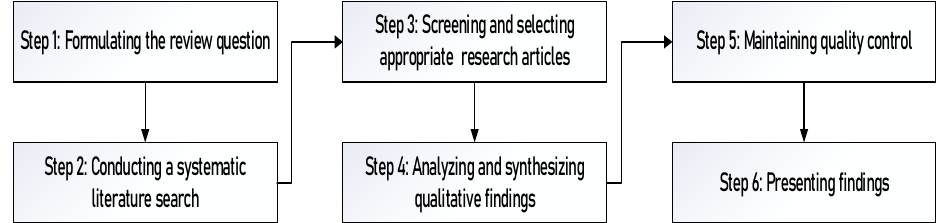
Figure 1. Phases of qualitative systematic review. The number of articles used as the basis for a systematic review is 100 article titles. title, which found 9695 titles. The number of titles was obtained from Portal: EBSCOhost demic Journals; Data base: Academic Search Complete; Journal category: peer reviewed; and published in the range of 2011 to